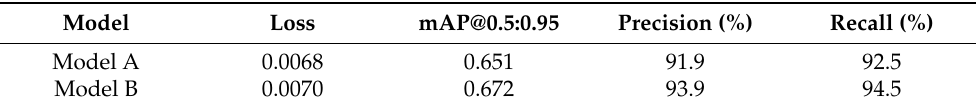
Table 5. Performance comparison between model A and model B.